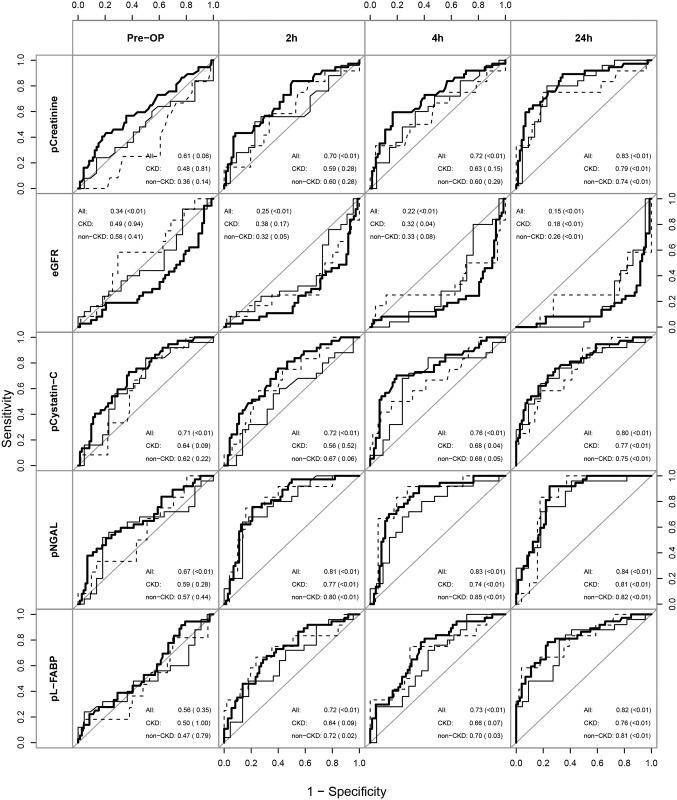
Diagnostic performance of biomarkers in plasma.Receiver operating characteristic curves (AUC-ROC) show discriminative abilities for preoperative risk stratification (pre-OP) and postoperative diagnosis of AKI (at 2h, 4h and 24h after CPB) for all patients (solid thick line) and separately for patients with (solid thin line) and without (dashed line) preexisting CKD. Indicated are AUC (p-value).